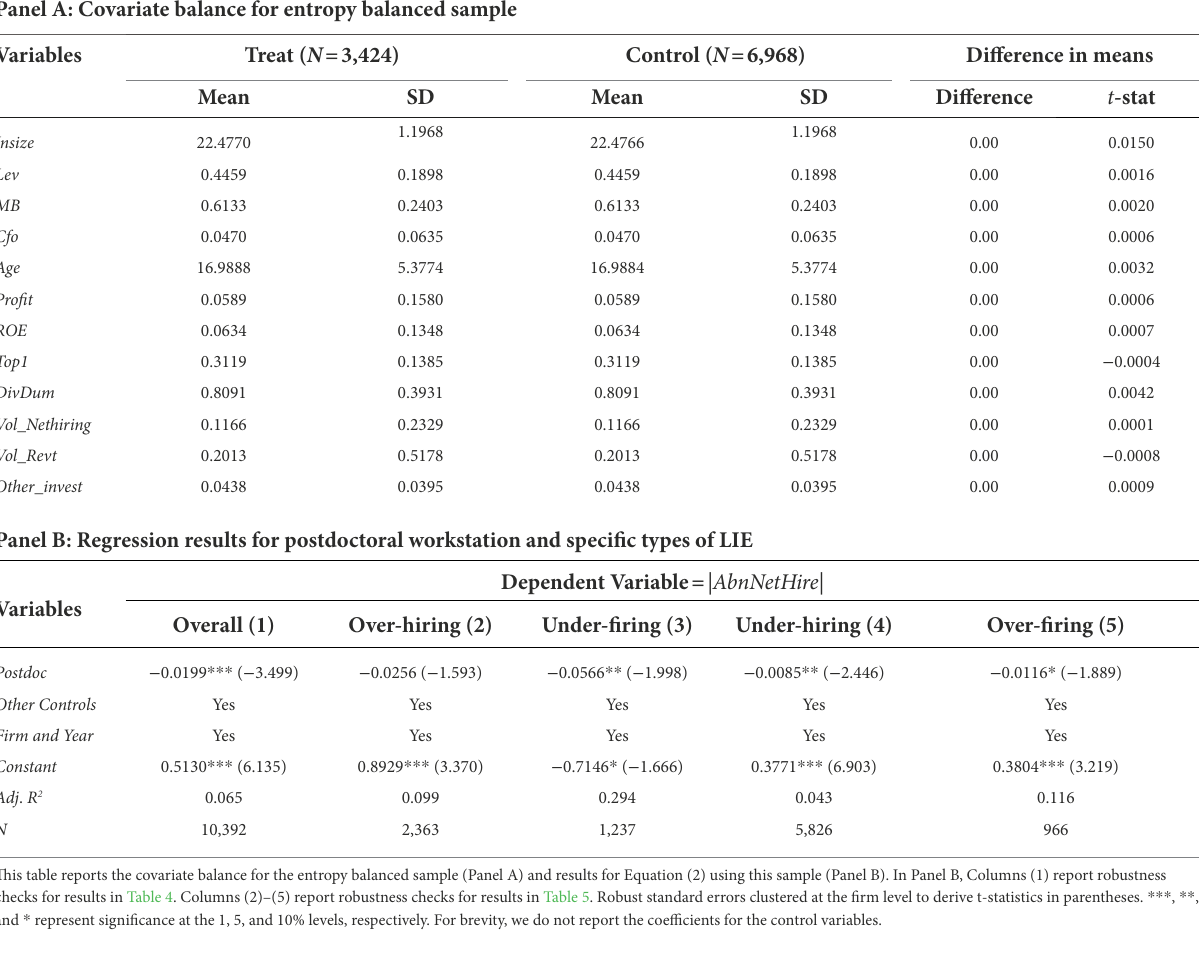
TABLE 7 Robustness checks using entropy balanced sample. Panel A: Covariate balance for entropy balanced sample